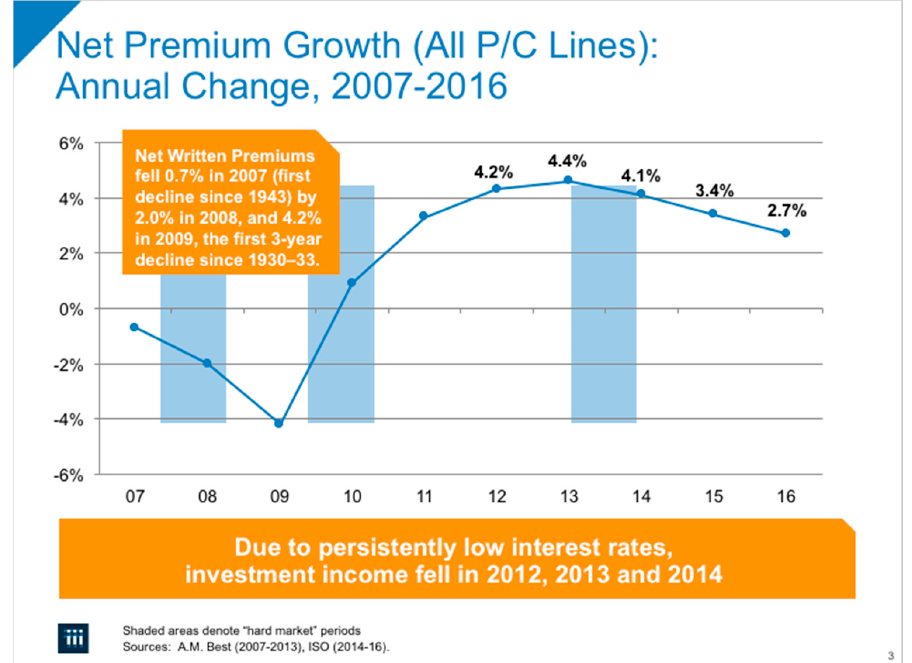
Figure 1. Net Premium Growth (All P/C Lines): Annual Change, 2007–2016.